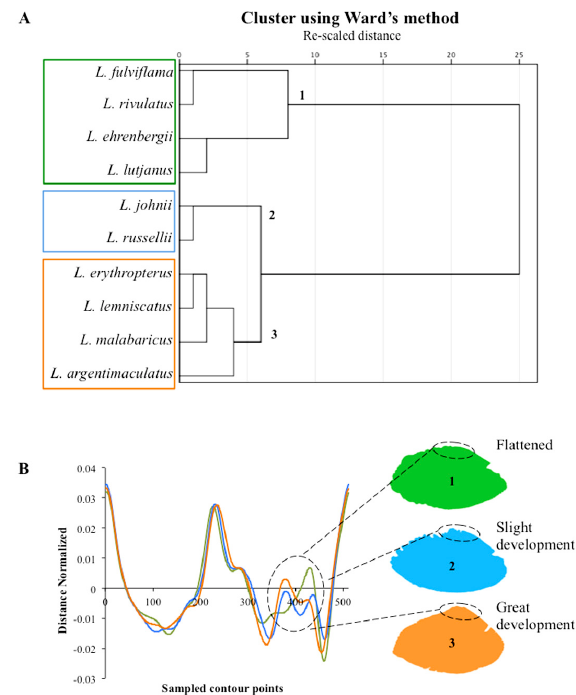
. 8. – A, hierarchical clustering of snappers from the Persian Gulf using antero-dorsal zone; B, mean signal of wavelet 5 for each group showing the morphology of the antero-dorsal zone of the oto- lith. Numbers indicate the otolith patterns